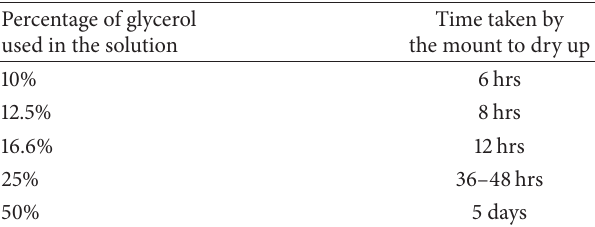
Table2:Associationbetweentheamountandtimetakenbyglycerol mount to dry